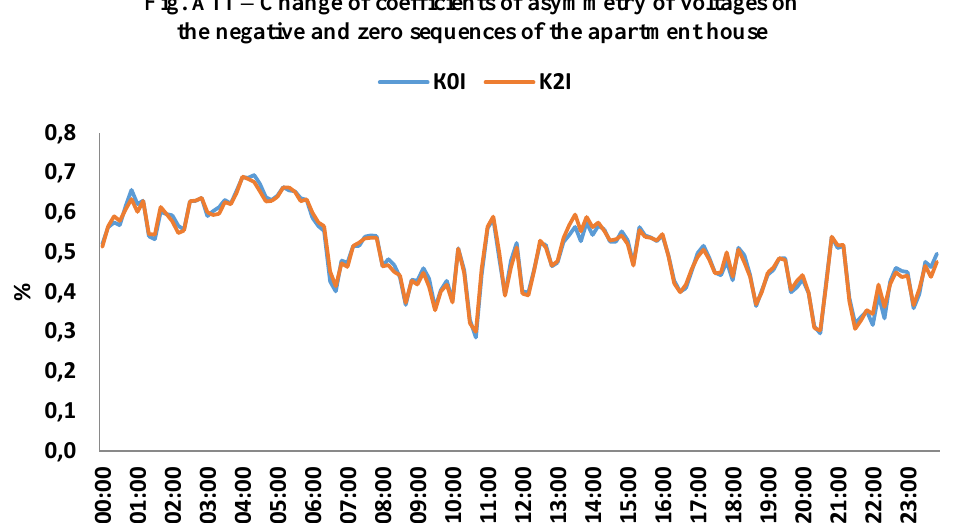
Fig. A11 – Change of coefficients of asymmetry of voltages on the negative and zero sequences of the apartment house